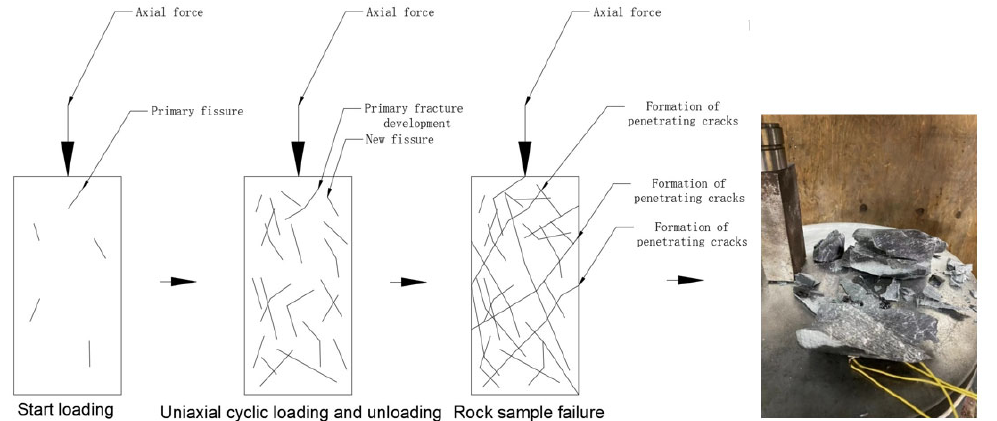
Figure 10. Internal cracks of a rock sample during uniaxial graded cyclic loading and unloading.